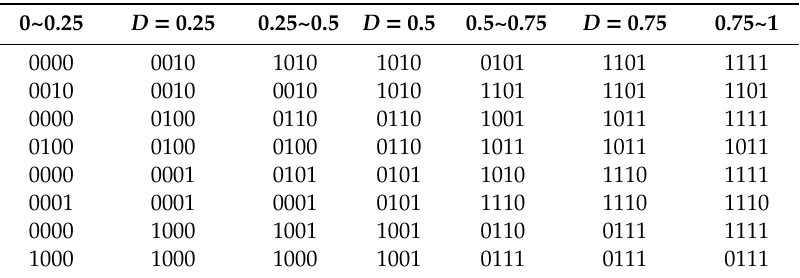
Figure 3. The main waveform of two parallel arms. ( a ) Mode 0.5 < D < 0.75, ( b ) Mode 0.25 < D < 0.5. Table 1. Two arms interleaved parallel coding.